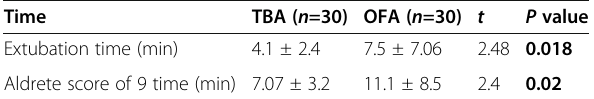
Table 1 Comparison between groups with regard to demographic data and duration of surgery Variable